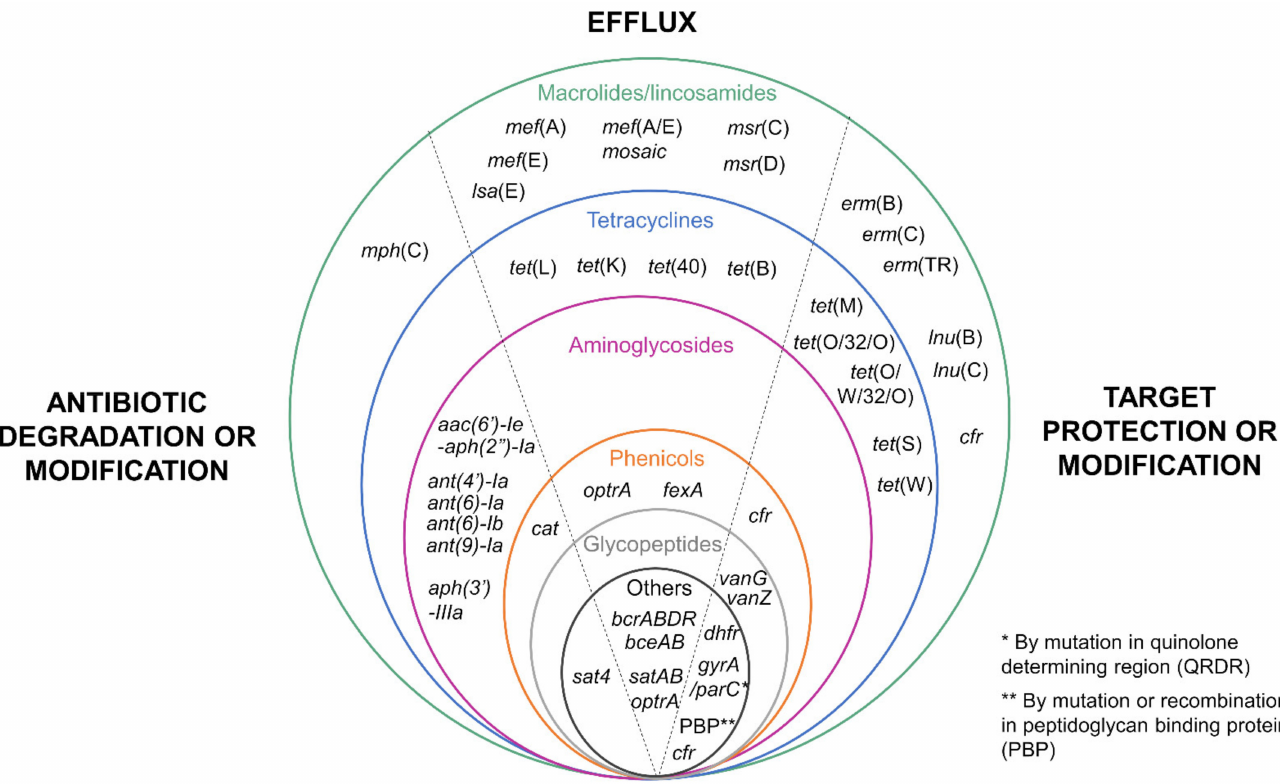
Figure 1. Resistance genes described in Streptococcus suis . The different genes conferring antibiotic resistance are classified in two ways: (i) according to their mechanism of resistance (on the left: degradation or modification of the target antibiotic; in the middle: efflux mechanisms; and on the right: target protection or modification, separated by a dotted line) and (ii) according to the family of antibiotics they target (circles of different colors: green for macrolides/lincosamides, blue for tetracyclines, pink for aminoglycosides, orange for amphenicols, gray for glycopeptides, black for other